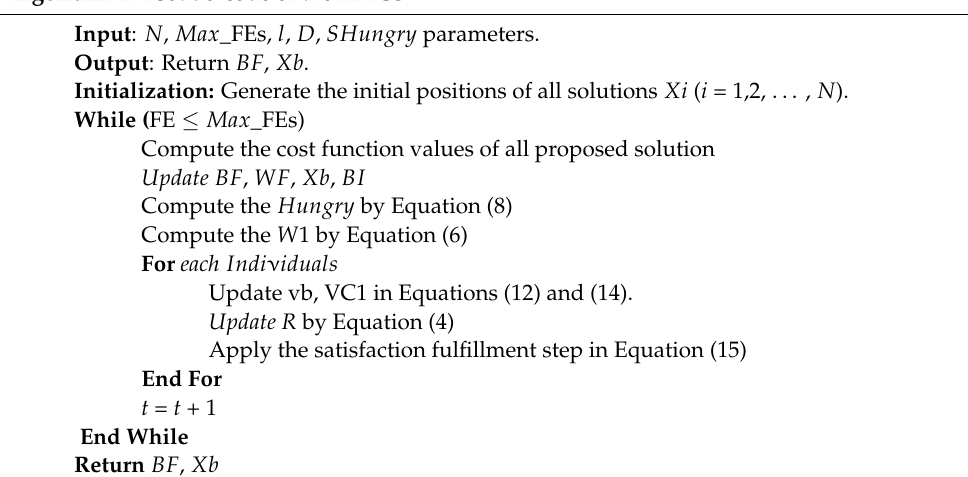
Algorithm 1 : Pseudo-code of the